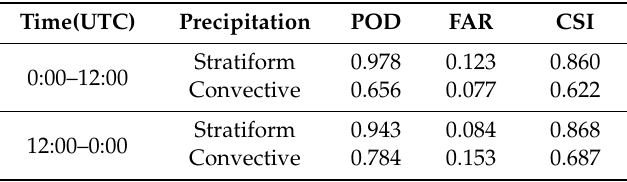
Table 3. Continuous analysis of Lianyungang in July 2012.